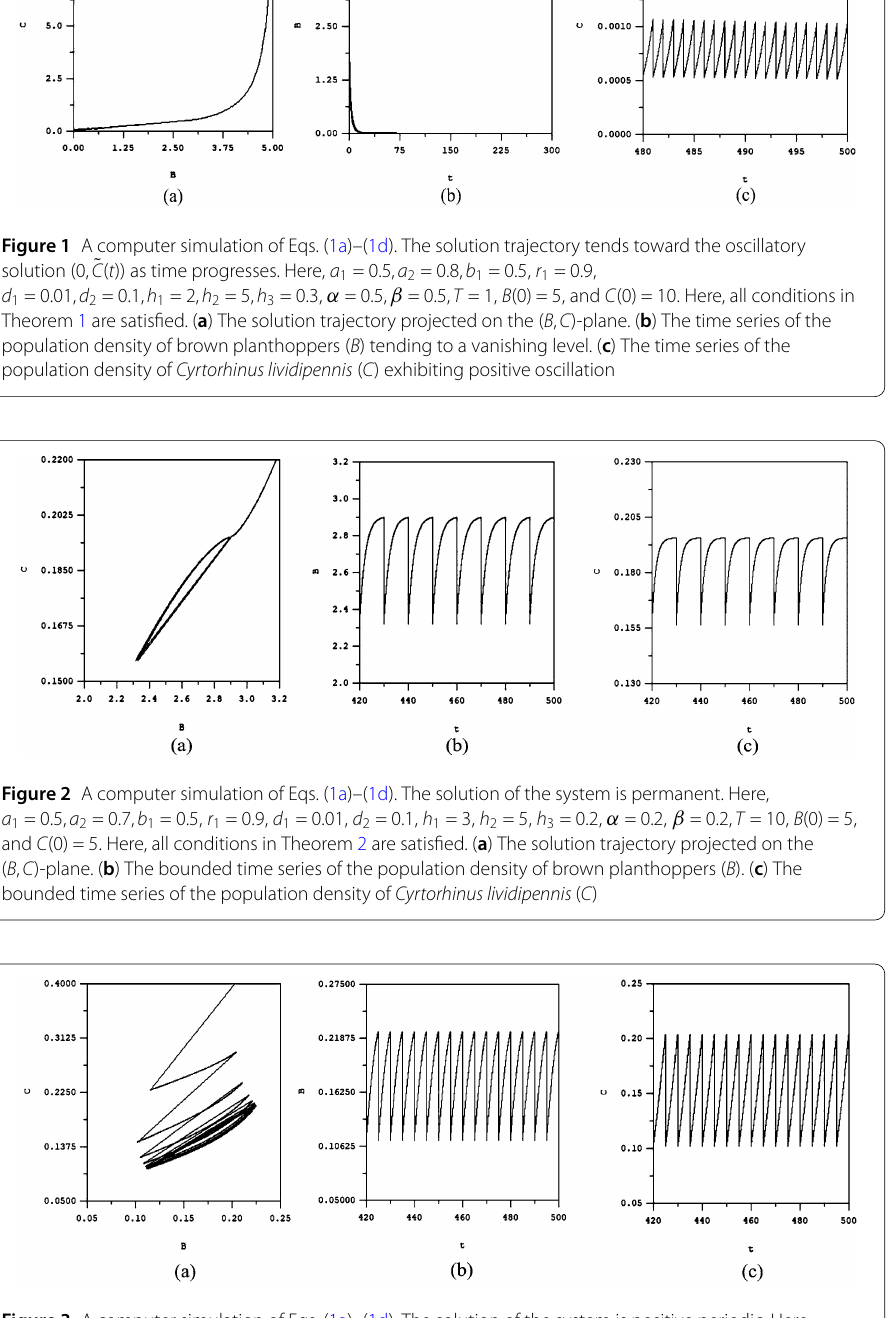
Figure 3 A computer simulation of Eqs. (1a)–(1d). The solution of the system is positive periodic. Here, a 1 = 0.5, a 2 = 0.4, b 1 = 0.5, r 1 = 0.9, d 1 = 0.01, d 2 = 0.2, h 1 = 0.3, h 2 = 2, h 3 = 0.5, α = 0.5, β = 0.5, T = 5, B (0) = 5, and C (0) = 5. Here, all conditions in Theorem 3 are satisfied. ( a ) The solution trajectory projected on ( B , C )-plane. ( b ) The time series of the population density of brown planthoppers ( B ) and ( c ) The time series of population density of Cyrtorhinuslividipennis ( C